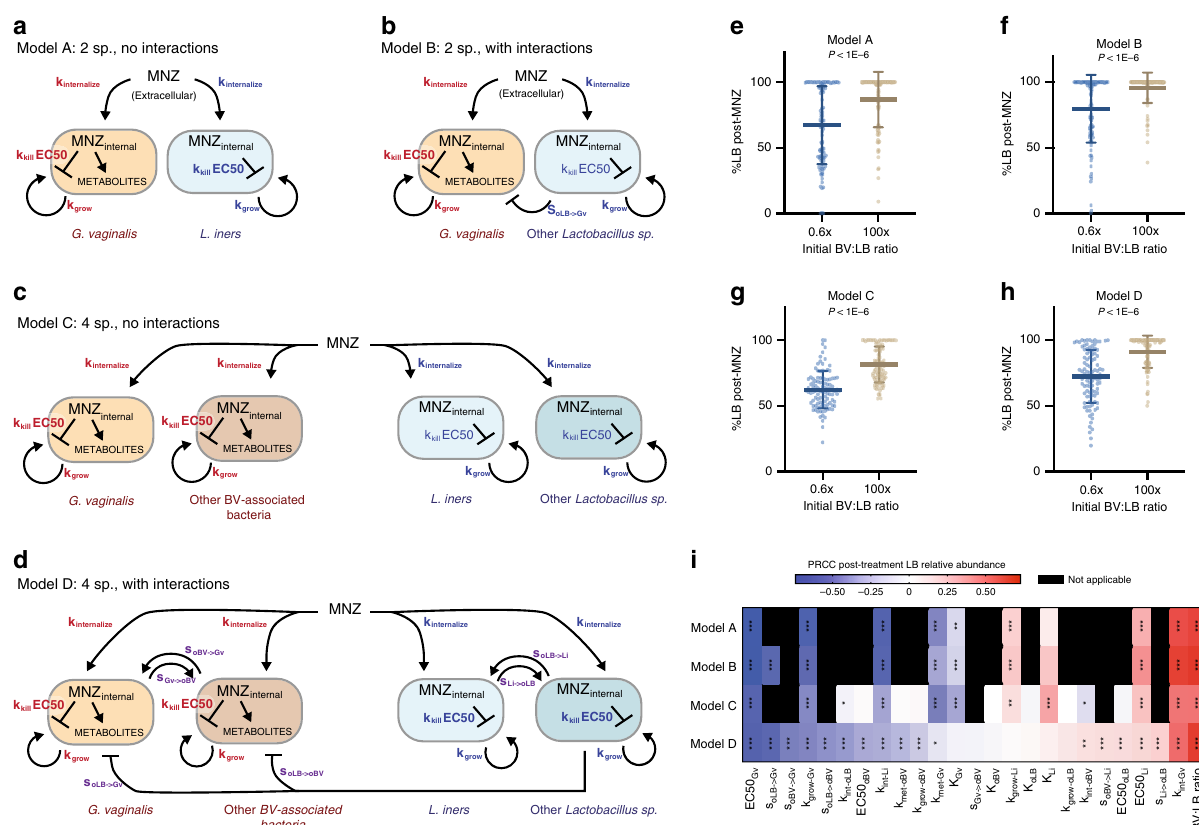
Fig. 4 High pre-treatment BV:LB ratio is predicted to reduce MNZ ef fi cacy in more complex microbial environments regardless of strain variability. a Original model structure validated in Fig. 2. b Two-species model with negative interaction between other Lactobacillus spp. (oLB) and Gv . c Four species model of Gv and Li with additional representative bacteria for BV-associated bacteria and Lactobacillus spp. d Four species model with interspecies interactions. Within BV-associated bacteria and Lactobacillus spp. interactions were simulated from mutualistic (both bene fi t) to commensal (one bene fi ts, the other is neutral). Inhibitory (amensal) interactions are included between D-lactic acid producing bacteria, other Lactobacillus spp., with both BV- associated bacteria. e – h Post-MNZ treatment (48 h, 500 μ g/ml) Lactobacillus spp. relative abundances at 0.6× and 100× BV-associated bacteria to Lactobacillus spp (BV:LB) ratios for each model type ( n = 100 independent simulations for each ratio, data are presented as mean ± SD). Each point represents a parameter set randomly sampled from physiological ranges in Supplementary Tables 2 and 3. Statistical analysis was completed using unpaired, two-sided t -tests: Model A ( p = 7.20 × 10 − 7 , t ratio = 5.32, df = 198), Model B ( p = 1.67 × 10 − 7 , t ratio = 5.649, df = 198), Model C ( p = 8.05 × 10 − 18 , t ratio = 9.725, df = 198), and Model D ( p = 1.70 × 10 − 13 , t ratio = 7.954, df = 198), which were corrected for multiple comparisons using the Benjamini and Hochberg method. i Signi fi cantly sensitive parameters were assessed by partial rank correlation for each model structure ( a – d ) in a global sensitivity and uncertainty analysis, multiple comparisons where adjusted for using Bonferroni correction (asterisks indicate signi fi cance as * p < 0.05, ** p < 0.01, *** p < 0.001). Source data are provided as a Source data fi